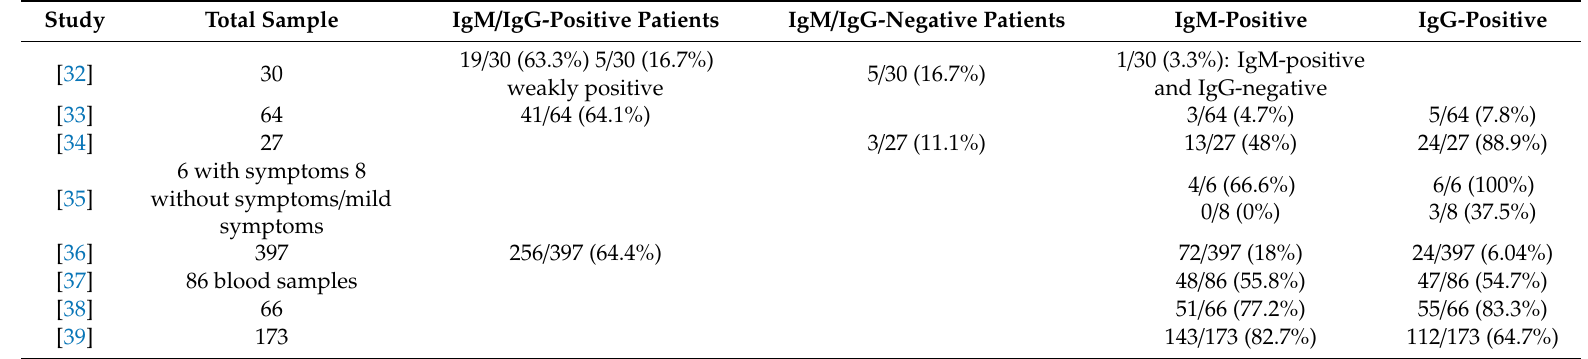
Table 3. Anti-SARS-CoV-2 IgM and IgG rates in the COVID-19-positive population sample.